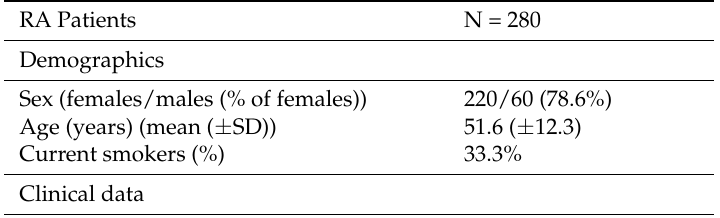
Table 1. Baseline characteristics of RA